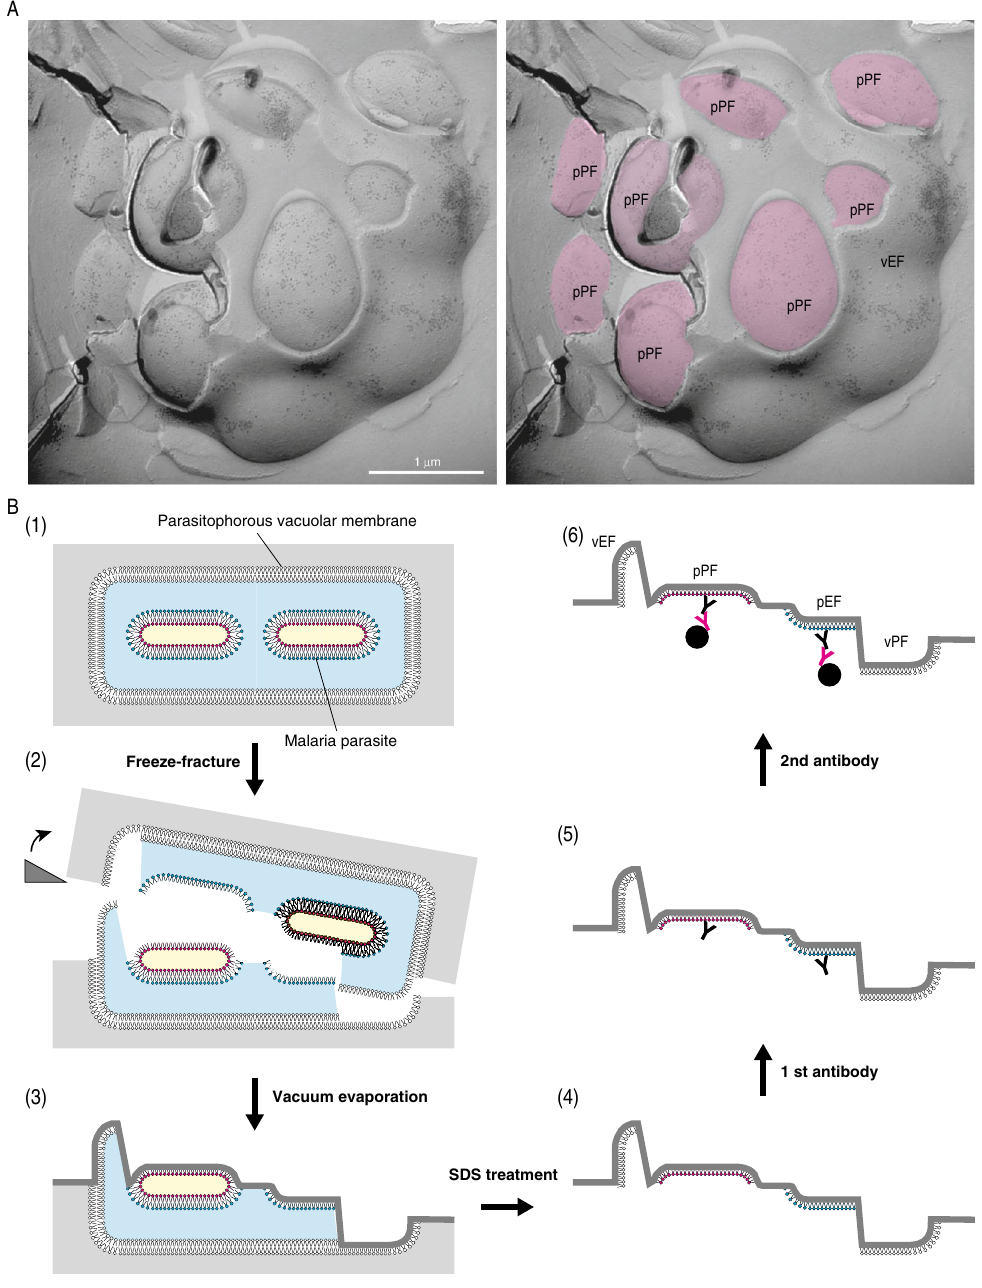
Figure 2. Outline of the QF-FRL method and GM3 localization in the membrane of live P. falciparum . ( A ) Freeze-fracture planes of P. falciparum at the schizonts stage consisting of maturing merozoites enclosed in a PV, comprising a single membrane bilayer. The P-faces are adjacent to the cytoplasm, and the E-faces to the exterior side. The labeling of anti-GM3 antibody was localized on both the P. falciparum EF (pEF) and P. falciparum PFs (pPF). In panel in A, pink represents the PF of the plasma membrane in P. falciparum . Scale bar: 1 μm. ( B ) Outline of the QF-FRL method in the P. falciparum - infected human erythrocyte. (1) QF: Live cells were quickly frozen without ice crystal formation. The metal contact freezing method was used in the present study. (2) Freeze-fracture: Frozen P. falciparum cells in human erythrocytes were fractured at below − 130 °C and under a high vacuum. Membranes were split into two leaflets, and the hydrophobic interface (i.e., the acyl chain side of the phospholipid monolayer) was exposed. (3) Vacuum evaporation: thin layers of carbon and platinum were deposited onto the hydrophobic interface of membranes to physically stabilize the molecules. Because platinum was evaporated at an oblique angle to the specimen’s surface (45°), protruding structures block the evaporating atoms to produce “shadows” behind the structures. Areas deficient in the platinum deposition, therefore, appeared to be electron-lucent under EM. Transmembrane proteins were seen as small bumps termed IMPs. (4) SDS treatment: Specimens were thawed and treated with an SDS solution to dissolve materials other than the lipid monolayer and integral membrane proteins, which were in direct contact with the carbon and platinum layer. This makes membrane proteins and lipid head groups accessible for antibody labeling (5). To visualize the antibody labeling under an electron microscopy, the first antibody was labeled with colloidal gold-conjugated secondary antibody on the replica specimens